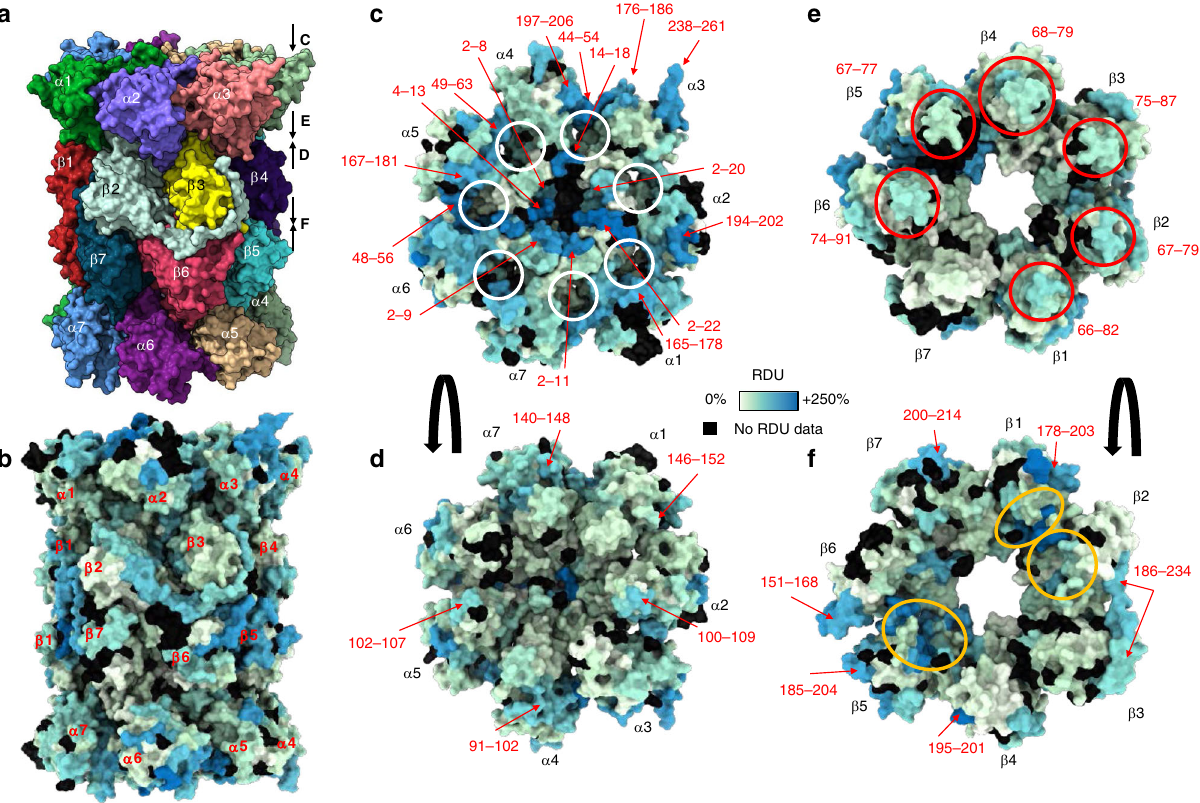
Fig. 2 HDX-MS of the std20S reveals a dynamic pore entrance and inter-ring interface. a , b Structure of the human std20S proteasome (PDB: 5LE5) 35 showing the four stacked αββα heptameric rings colored by subunit ( a ) or relative deuterium uptake (RDU) ( b ). c – f Their solvent accessibility is represented on each face of the α -ring (solvent interface ( c ) and β -ring interface ( d )) and β -ring ( α -ring interface ( e ) and β -ring interface ( f )) as the sum of consolidated relative deuterium uptakes between 0.5 and 30 min (described in Fig. 1b, c). The α -pockets (docking sites for the C-termini of PA28 regulators) are circled in white in c . Regions discussed in the text are indicated with red arrows and the moderately fl exible/accessible bulges at the interface between the α - and β -ring are circled in red in e . The corresponding residues are indicated in red around the structures. Active sites are circled in orange ( f ). The ring faces visualized in d – f are indicated by arrows on the right of the structure in a